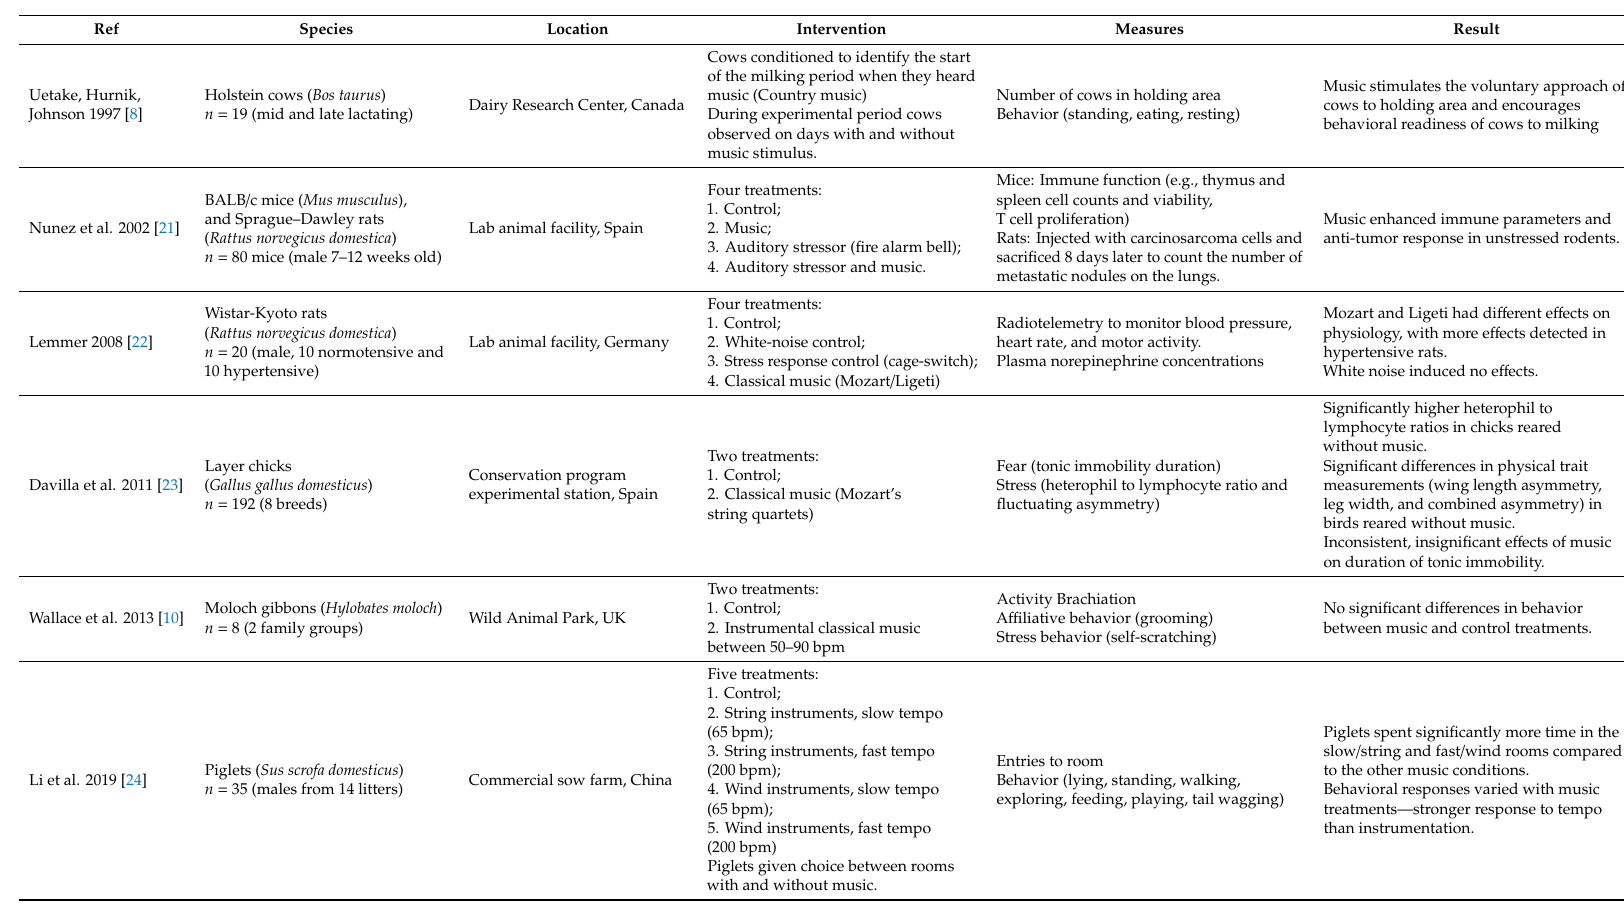
Table 2. Sample of studies examining e ff ects of auditory enrichment on health and behavior of non-canine species. Ref Species Location Intervention Measures Result